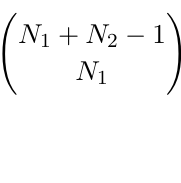
value of (cid:20) ). One such path for the algebra Y j molecules to be distinguishable, we get ( N ( N + N )! possible orderings in the Miura 1 2